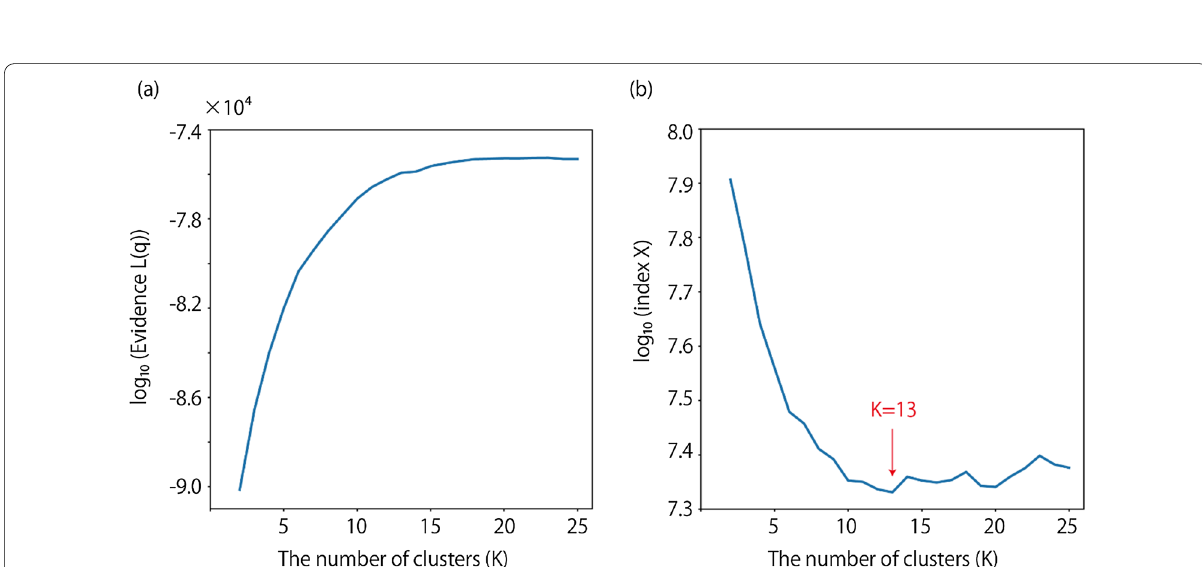
Fig. 3 Grid search results of Evidence L ( q ) and index X for the number of clusters ( K ) at Site